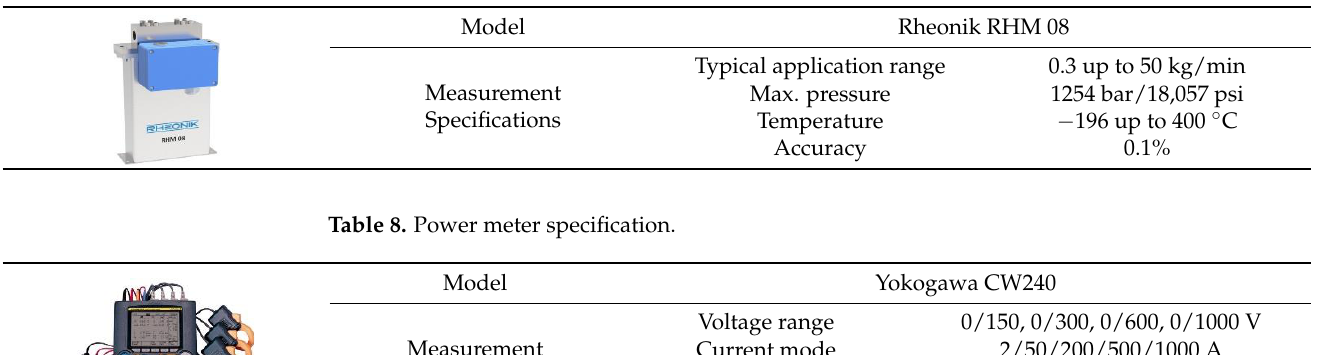
Table 6. Data logger specification.